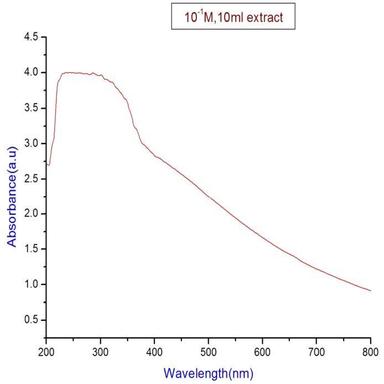
ltraviolet spectra of Moringa oleifere leaf Extract